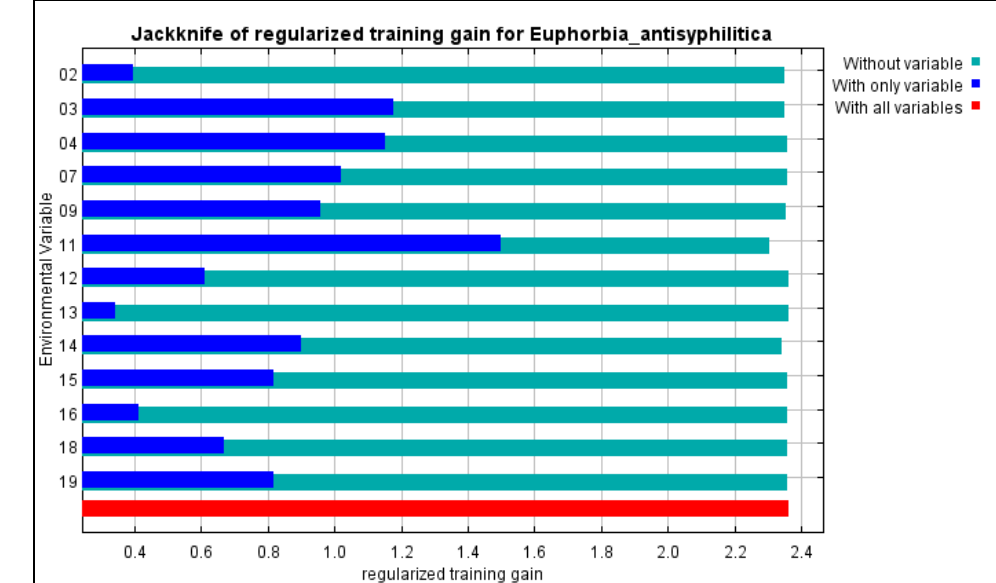
Figure 3. Jackknife regularized test of gaining for candelilla.